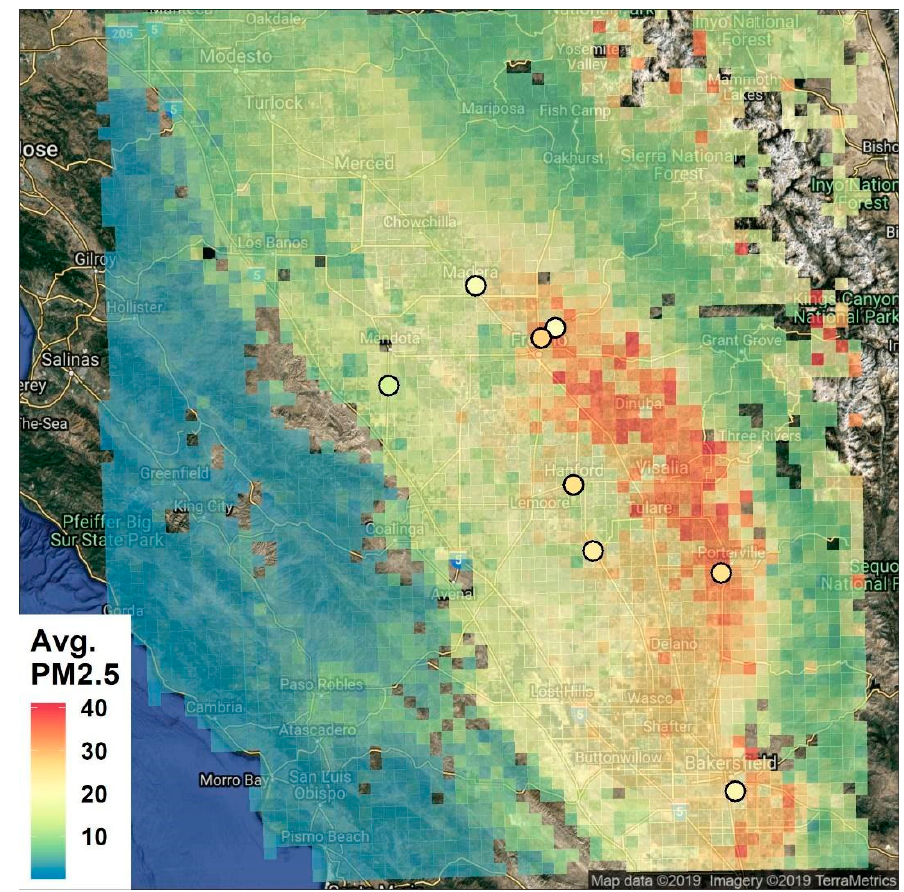
Figure 5. Map of Central Valley, CA with predicted PM 2.5 concentrations from applying AERONET-DRAGON calibration Model 3 to MISR AOD 550 nm (4.4 km grid), and observed mean PM 2.5 concentrations (for the whole DRAGON campaign period) at 8 EPA AQS sites (dots).